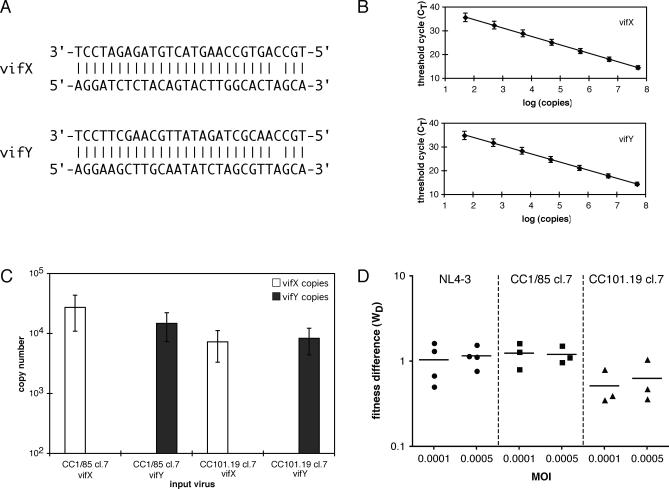
The Use of the TaqMan QPCR Assay to Determine Replicative Fitness(A) The sequences (3′ to 5′) of the vifX and vifY TaqMan probes are shown on top, the sequences of the vifX and vifY vif alleles are shown below. Each probe differs from its target sequence by one nucleotide because the vifX probe was designed to match the consensus for HIV-1 subtype B vif in this region. Each probe binds to the sense strand of proviral DNA. The probes are aligned to the target sequences with bars indicating positions of identity. The two probes and the two vif alleles differ at 11 nucleotides each. The vifY vif allele that was engineered to tag the reference viruses contains only synonymous changes.(B) The plot demonstrates the working range and reproducibility of the QPCR assay. The average threshold cycle (CT) values obtained in six representative multiplexed assays are shown ± standard deviation (SD). In each assay, seven serial dilutions of the standard plasmid ranging from 5 × 107 to 5 × 101 DNA templates were measured using TaqMan probes specific either for the vifX (Cy5 fluorescence, top panel), or the vifY sequence (FAM fluorescence, bottom panel). The correlation coefficients (R
2) of the two standard curves were >0.995 and the PCR efficiencies were >90%.(C) The specificity of the QPCR assay is depicted. Four independent PBMC cultures were singly infected with one of the CC1/85 cl.7 or the CC101.19 cl.7 viruses containing either the vifX or the vifY vif sequence. Genomic DNA from each culture was PCR amplified and then used in the multiplexed TaqMan QPCR assay, as described in Materials and Methods. The average number of copies of each vif allele detected per QPCR reaction for each of the four mono-infections from six representative experiments is shown ± SEM. The lower limit for copy number is set to 100 for plotting purposes, although 50 copies can be quantified reproducibly, and the allele that was not present in the infection was never detected in any quantifiable amount in singly infected cultures.(D) The vif tag has no effect on replicative fitness. Competitive replication assays were performed in which viruses bearing the NL4–3 (circles), CC1/85 cl.7 (squares), or CC101.19 cl.7 (triangles) env genes and the vifX vif allele were competed against viruses bearing the same env genes but the vifY sequence. The fitness differences (WD) at each indicated MOI were calculated as described in Materials and Methods. The calculated fitness differences of each vifX virus relative to the vifY virus in each experiment are depicted, with the bar showing the mean value of three or four independent experiments. A fitness difference of 1 arises when the two competing viruses are of equal replicative fitness; a value < 1 indicates that the virus with vifY had the greater replicative fitness, > 1 that the virus with vifX was fitter.